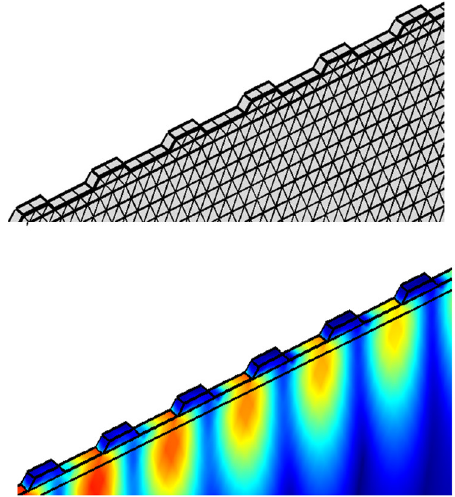
Figure 5. Example of mesh construction and solution in the form of mechanical displacement components for a fragment of topology.